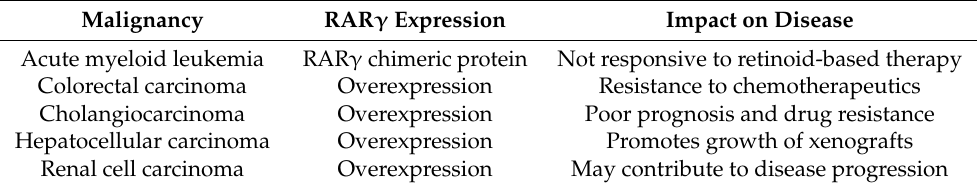
Table 1. Over and aberrant expression of RAR γ in human cancers. Malignancy RAR γ Expression Impact on Disease Acute myeloid leukemia RAR γ chimeric protein Not responsive to retinoid-based therapy Colorectal carcinoma Overexpression Resistance to chemotherapeutics Cholangiocarcinoma Overexpression Poor prognosis and drug resistance Hepatocellular carcinoma Overexpression Promotes growth of xenografts Renal cell carcinoma Overexpression May contribute to disease